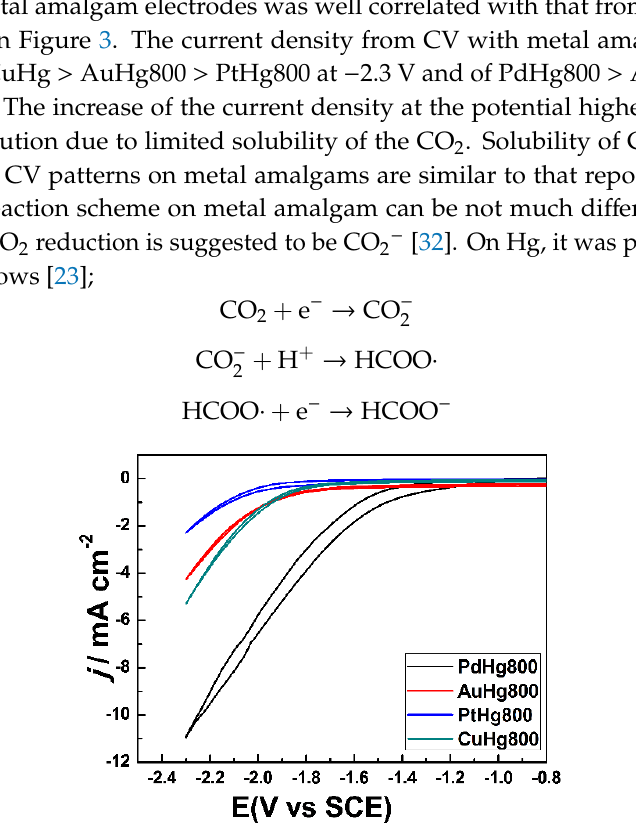
Figure 4. Cyclic voltammetry (CV) analysis in CO 2 saturated 0.1 M KHCO 3 solution at the scan rate of 50 mV·s −1 , PdHg800, AuHg800, PtHg800 and CuHg800.